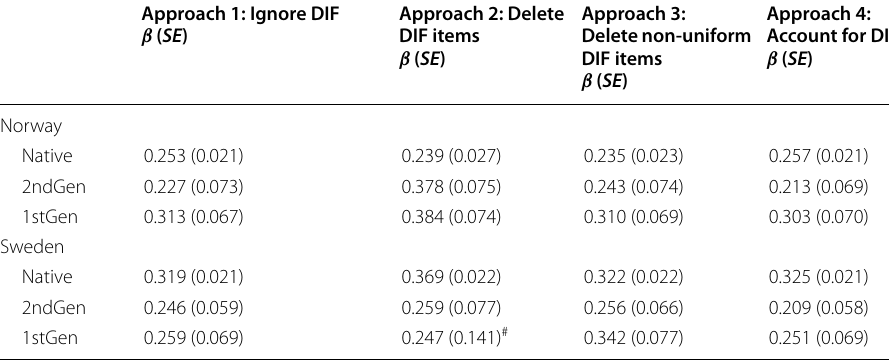
# The regression coefficient of the 1stGen group was found to be significantly different from that of the native group within this approach ( p <